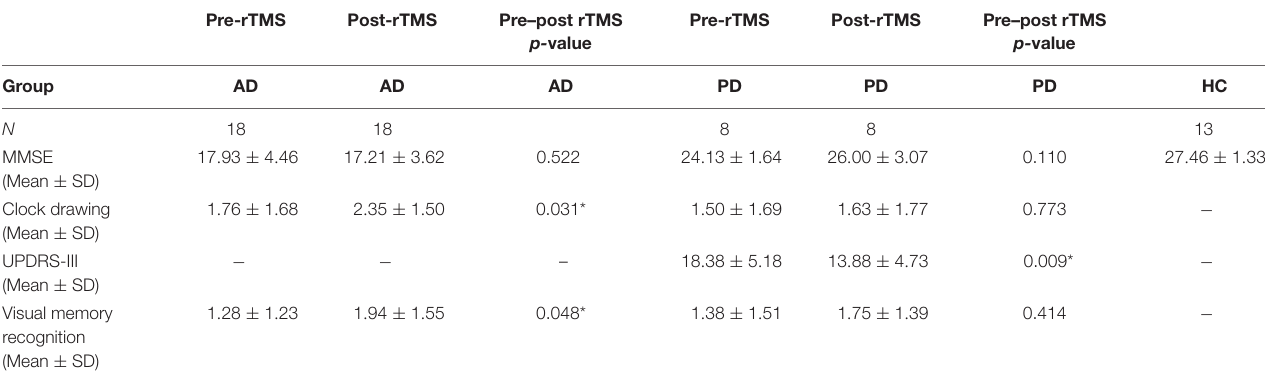
TABLE 2 | The assessments of motor and cognitive functions of health control (HC), AD, and PD groups at pre and post-rTMS.